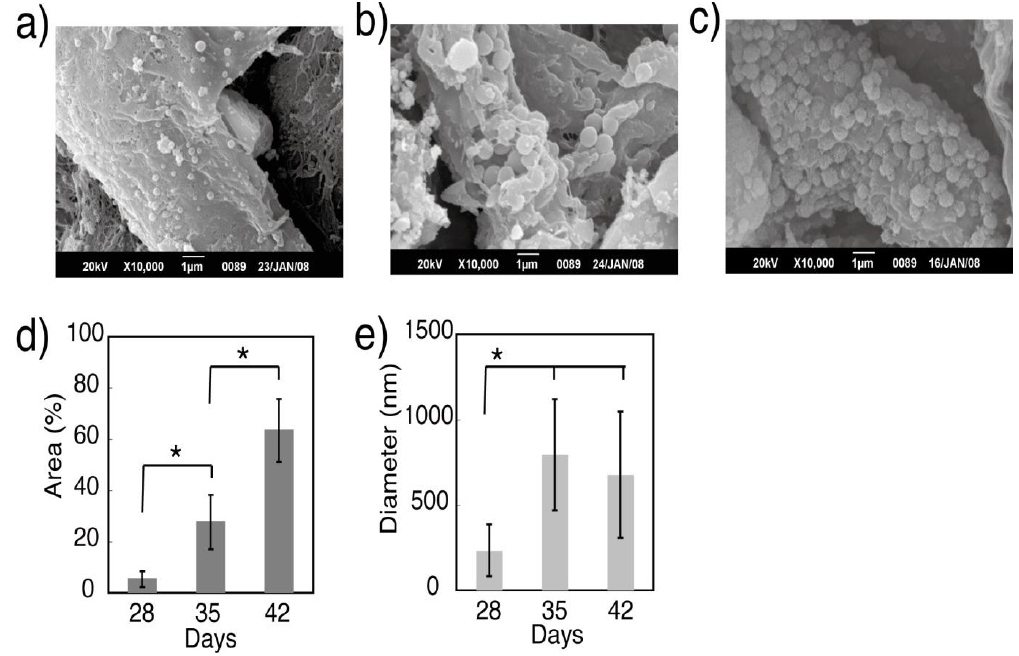
Figure 5. ( a–c ) Scanning electron micrograph (SEM) images indicating that mineralized matrix vesicles on cell membranes increased over the duration of the culture period (a; day 28, b; day 35, c; day 42); ( d ) Area ratio occupied by mineralized vesicles on single cell; ( e ) Alteration of mineralized vesicle mean size. For (d) and (e), * indicates significant difference (P <